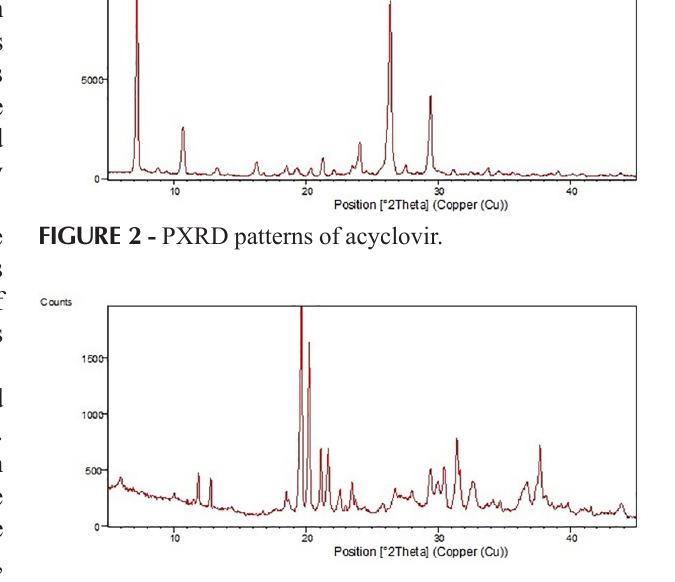
FIGURE 3 - PXRD patterns of CA1 (Acyclovir : Tartaric acid (1:6)).